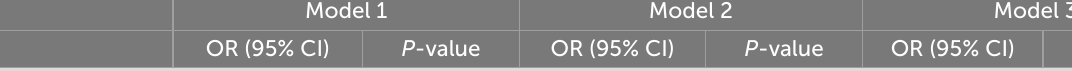
TABLE 4 Associations of quartile of α -tocopherol intake with low cognitive performance.